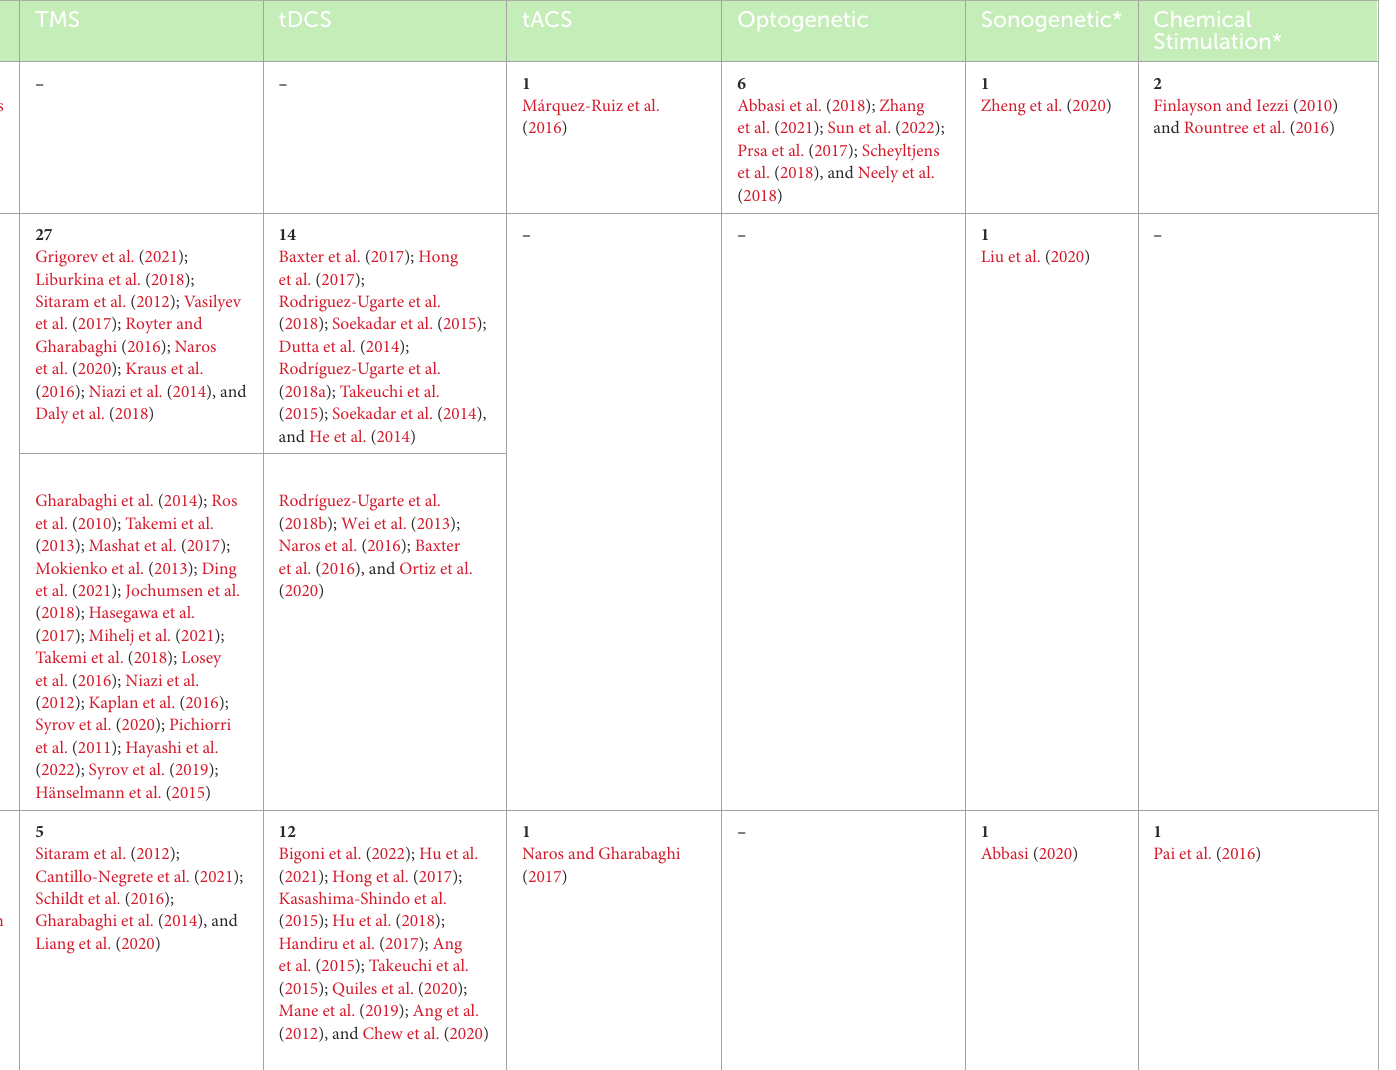
TABLE 2 Mapping between participants and stimulation techniques identified in the selected